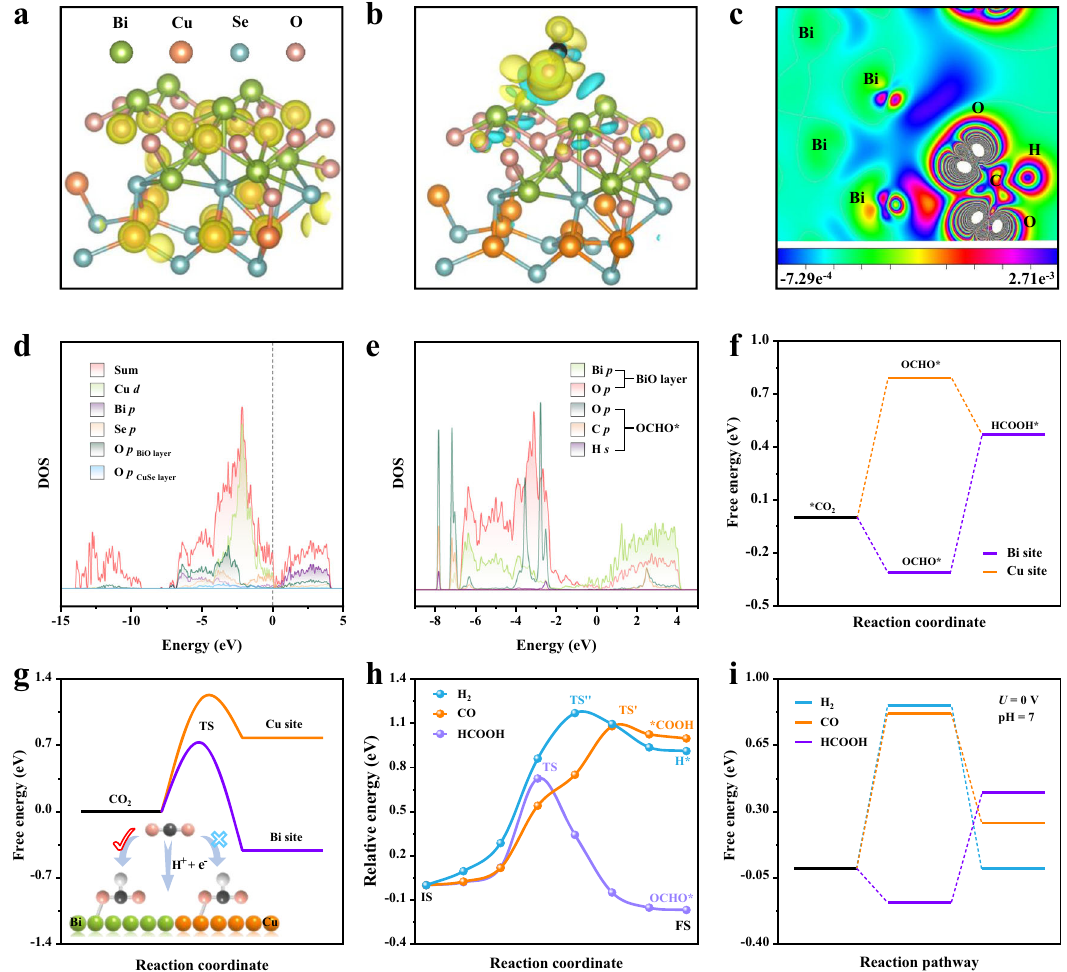
Fig. 6 DFT calculations. a Charge density of BiCuSeO after CO 2 RR. b Charge density difference of key reaction intermediates OCHO* on BiCuSeO during the CO 2 RR . The isosurfaces level is 0.002213 au. The yellow and blue shadows correspond to the charge accumulation and depletion, respectively. c Corresponding slice image of Fig. 6b along the (010) face. d Total density of states (Sum), Cu d , Bi p , and Se p orbitals PDOS, and O p orbitals PDOS obtained, respectively, from BiO and CuSe layers for BiCuSeO during CO 2 RR e PDOS of p orbitals for Bi and O atoms on BiO layer, PDOS of p orbitals for O and C atoms from OCHO*, and PDOS of H s orbital from the adsorbed OHCO*. f The adsorption free energy of OCHO* adsorbed on the Cu and Bi sites. g The kinetic energy barrier of adsorbed OHCO*. h The relative energy along the formation OCHO*, *COOH and H* species on the BiCuSeO. i Gibbs free- energy diagram of CO 2 electroreduction to formate, CO 2 electroreduction to CO, and HER at pH =